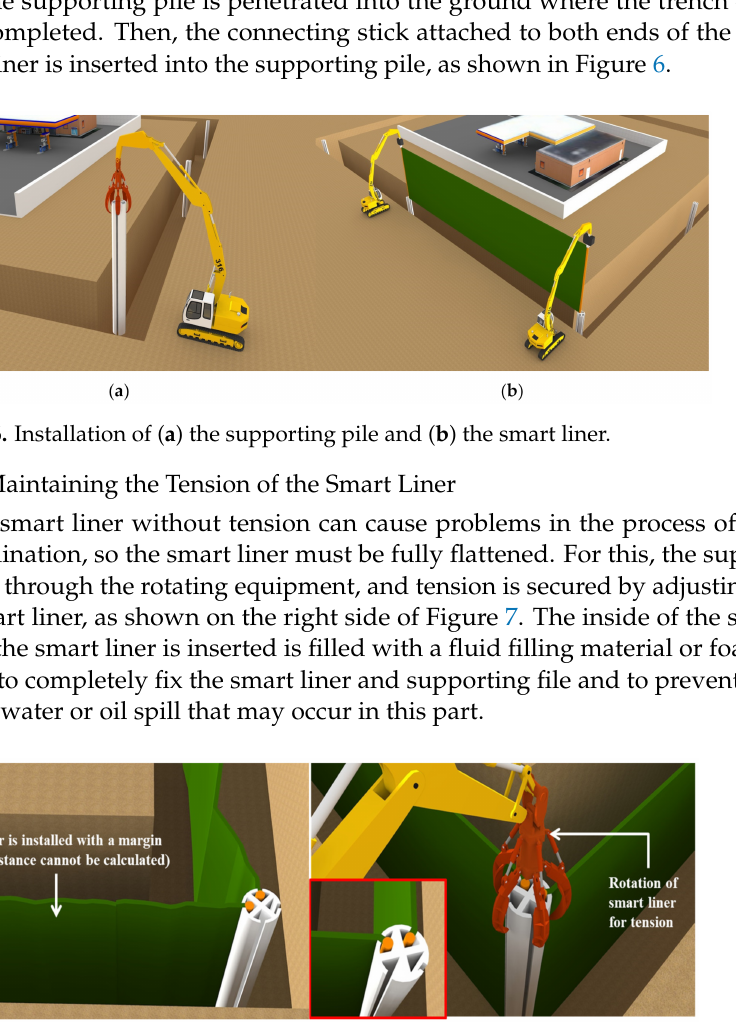
Figure 7. Maintenance method for the tension of the smart